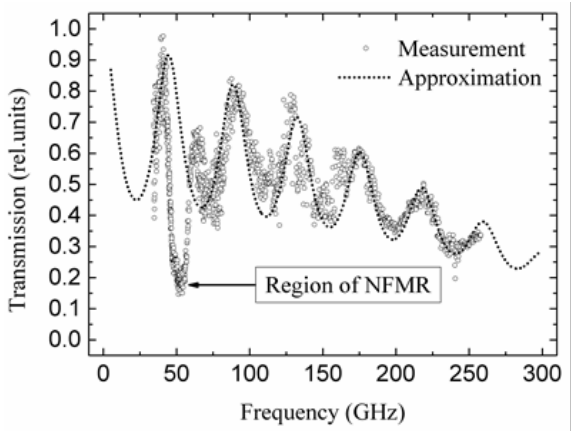
Fig. 4. Frequency dependence of the transmission coefficient of composite based on 60 wt.% BaFe 12 O 19 ferrite and urethane-alkyd